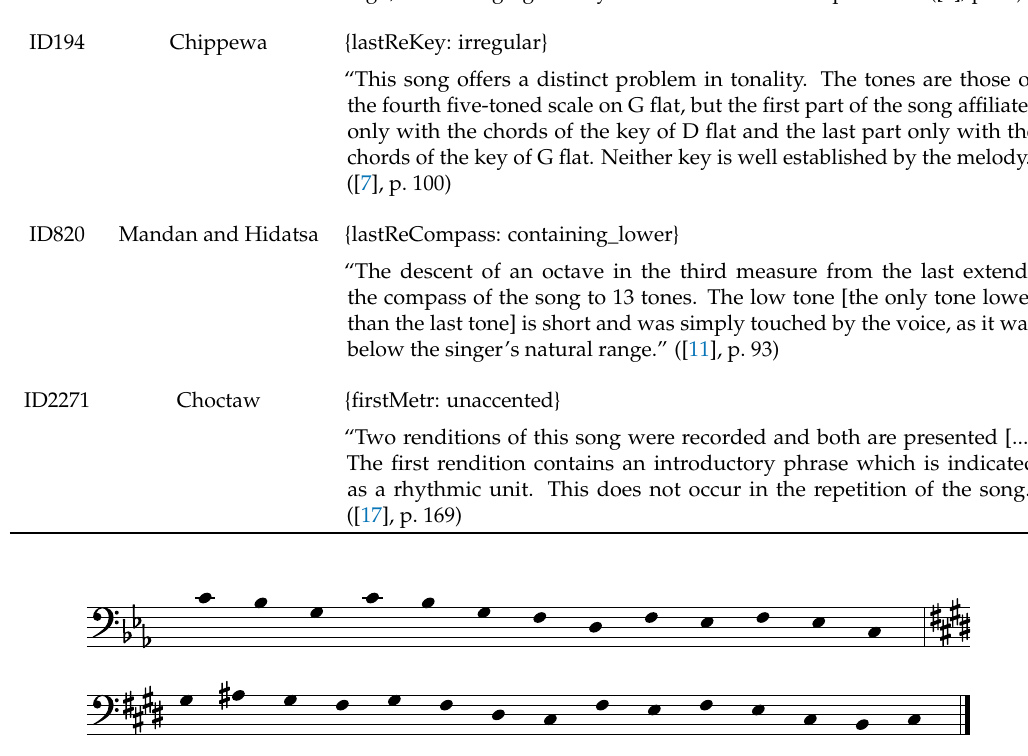
Figure 5. Chippewa song ID125, transcribed in outline ([7], p.